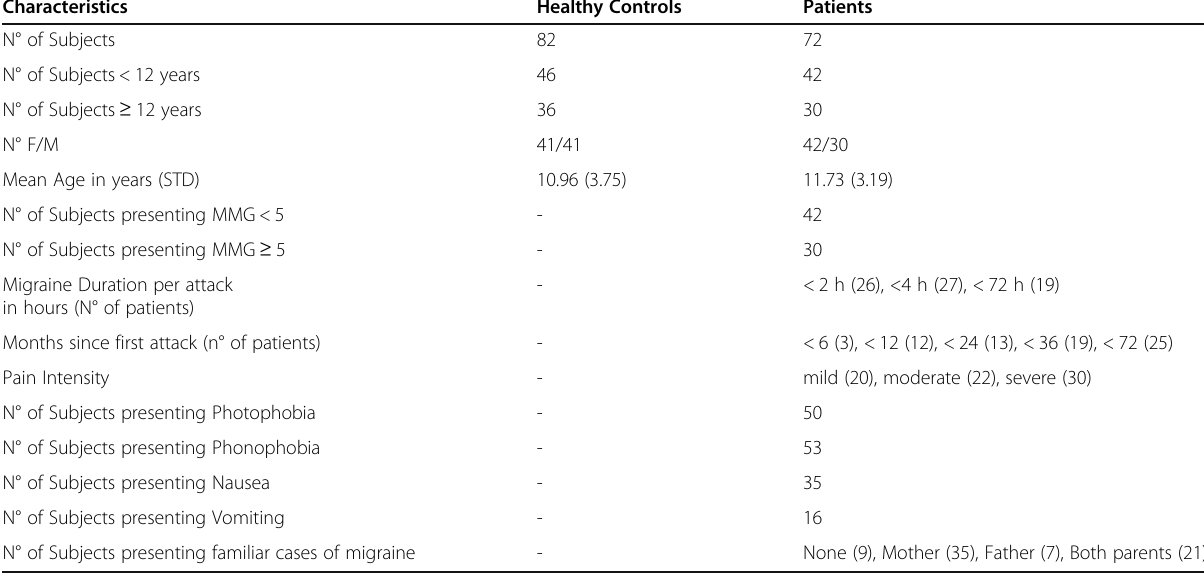
Table 2 Main demographic and clinical characteristics of healthy controls and patients affected by migraine without aura.